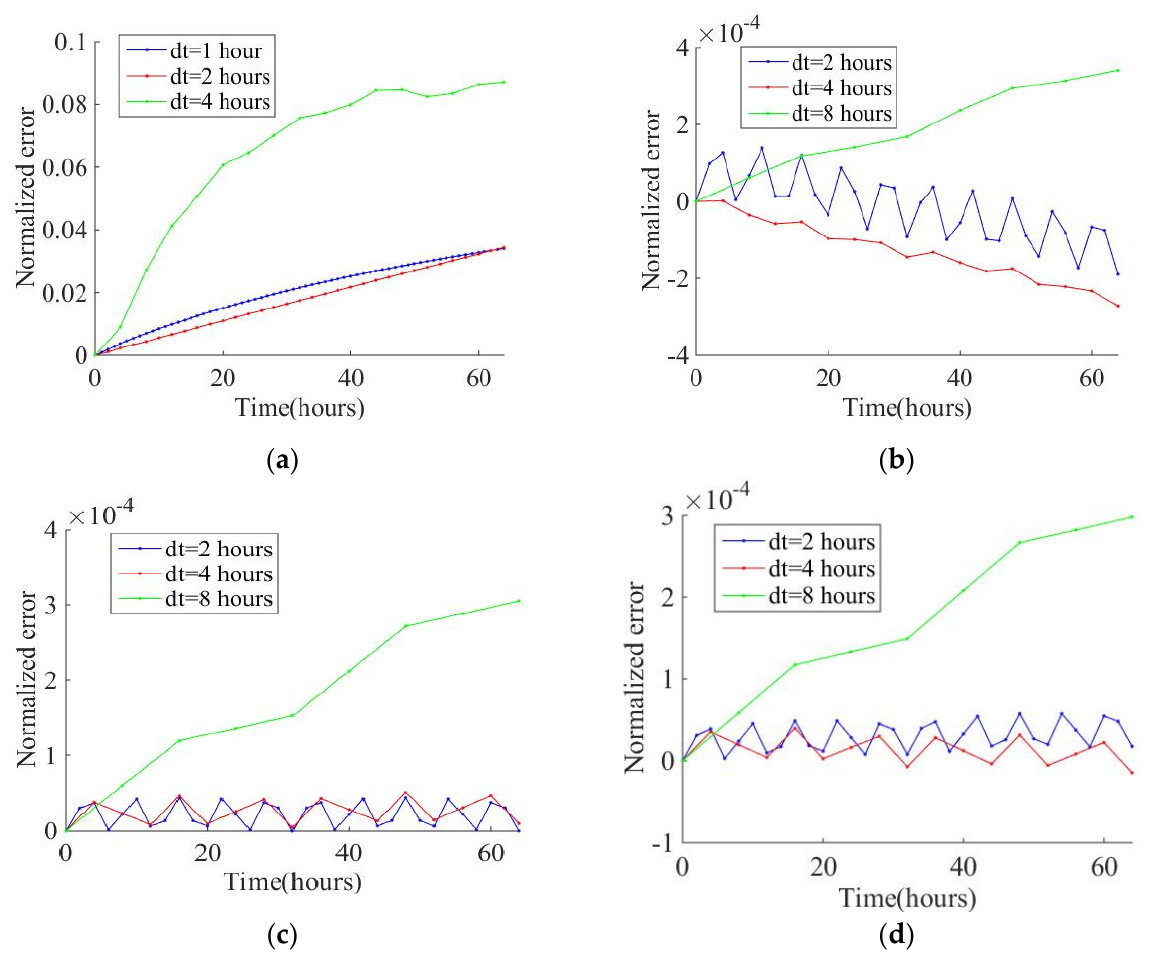
Figure 7. The history of mass relative error on icosahedron sphere grids with refinement level 4. Advection of the height field is eastward along the equator by SL method for different interpolation methods ( a ) Linear interpolation; ( b ) Poly-LSQ; ( c ) global RBFs; ( d ) local RBFs.